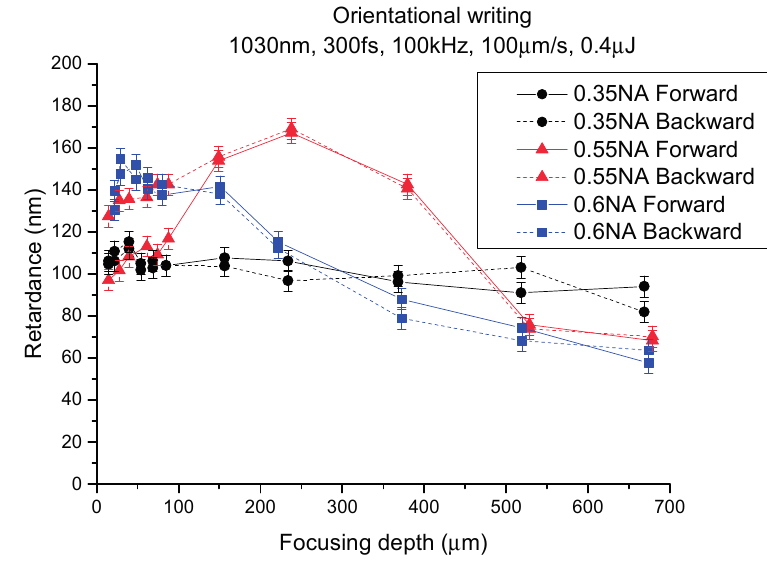
Figure 2. Influence of the focusing depth of the orientational writing effect for fixed pulse energy of 0.4 μ J/pulse (full lines for the forward + X direction and dotted lines for backward − X direction). The parameter of the study is the kind of focusing optics: 0.6 NA aspheric lens (blue curve), 0.35 NA microscope objective (black curve) and 0.55 NA microscope objective (red curve). The others laser parameters are as follows: 1030 nm, 300 fs, 100 kHz, 100 μ m/s, and polarization parallel to the scanning direction ( Xx